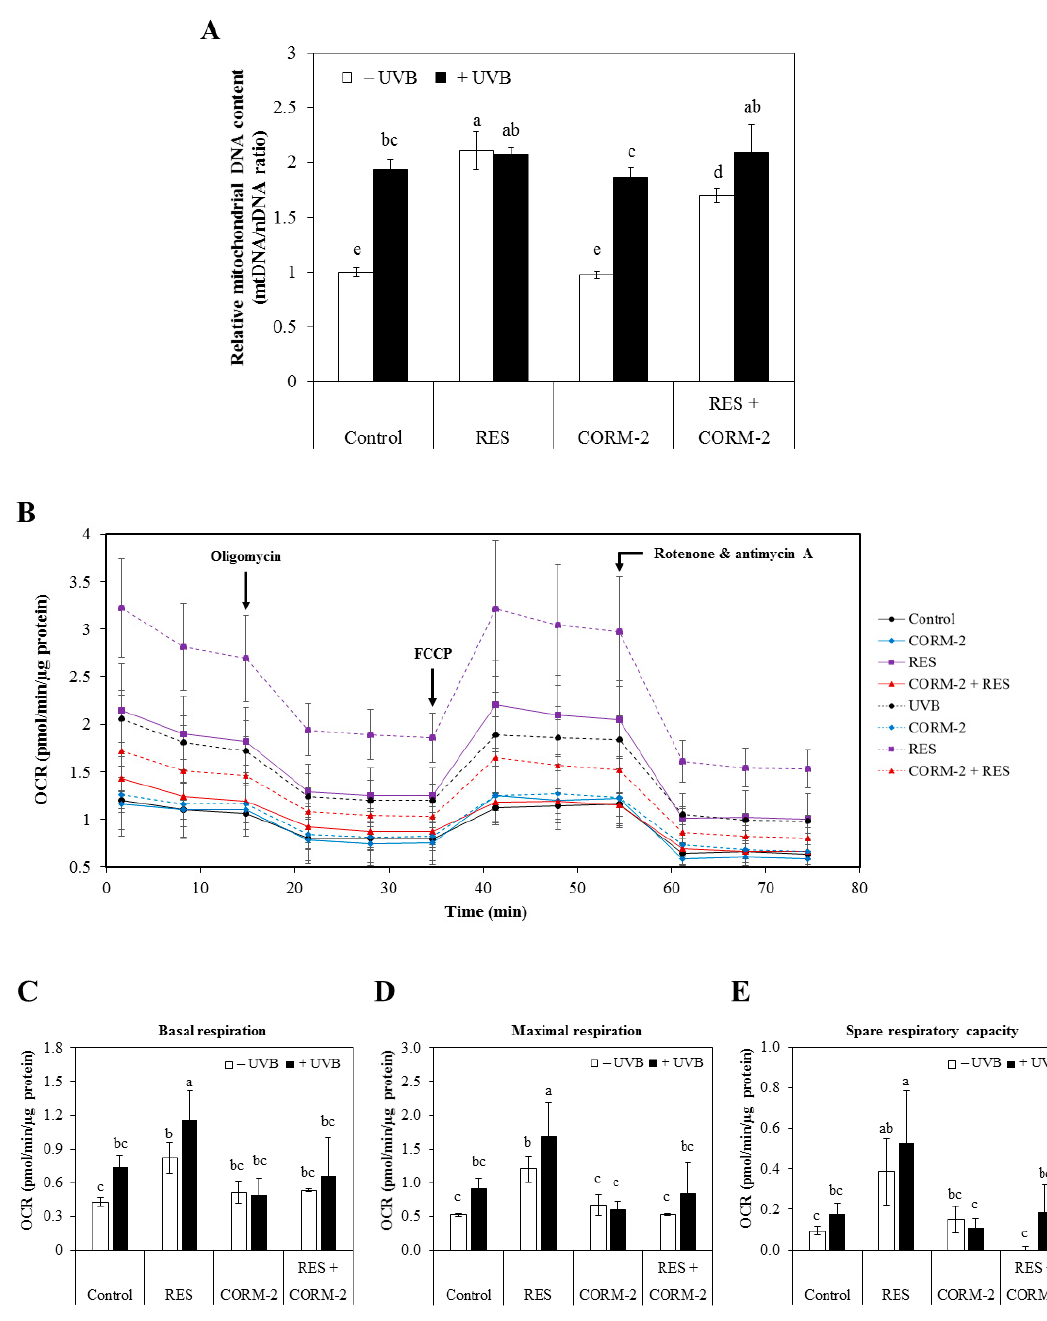
Figure 2. Modulation of mitochondrial DNA quantification and respiration by RES and / or CORM-2. ( A ) RES, but not CORM-2, increased the ratio of mitochondrial DNA to nuclear DNA, indicative of increased mitochondrial biogenesis. UVB also induced mitochondrial biogenesis and was maintained in cells pre-treated with RES and CORM-2, suggesting that mitochondrial number is optimized to prevent oxidative damage. ( B ) In general, mitochondrial respiration was increased by UVB and was substantially increased further in cells pre-treated with RES. CORM-2 mildly inhibited mitochondrial respiration to the control level. Mitochondrial OCR was measured by sequentially applying different mitochondrial inhibitors using Seahorse Mito Stress Test. Mitochondrial OCR related to key parameters of mitochondrial function were derived such as ( C ) basal respiration, ( D ) maximal respiration, and ( E ) spare respiratory capacity. RES increases OCR linked to key parameters of respiration while